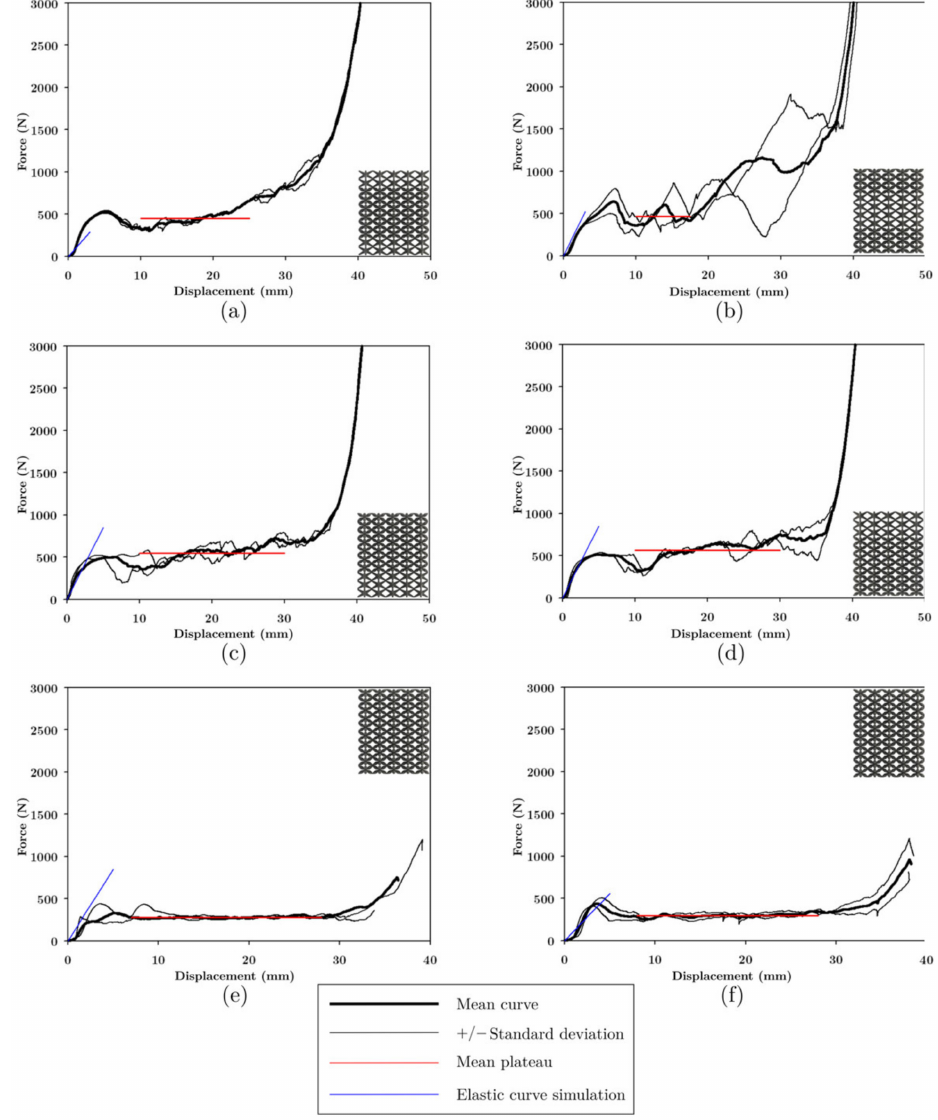
Figure 20. Force-displacement curve of LLS manufactured with PLA. ( a ) HM-LM-HM, ( b ) LM-HM-LM, ( c ) HM-IM-LM, ( d ) LM-IM-HM, ( e ) LM-IM-LM, and ( f )